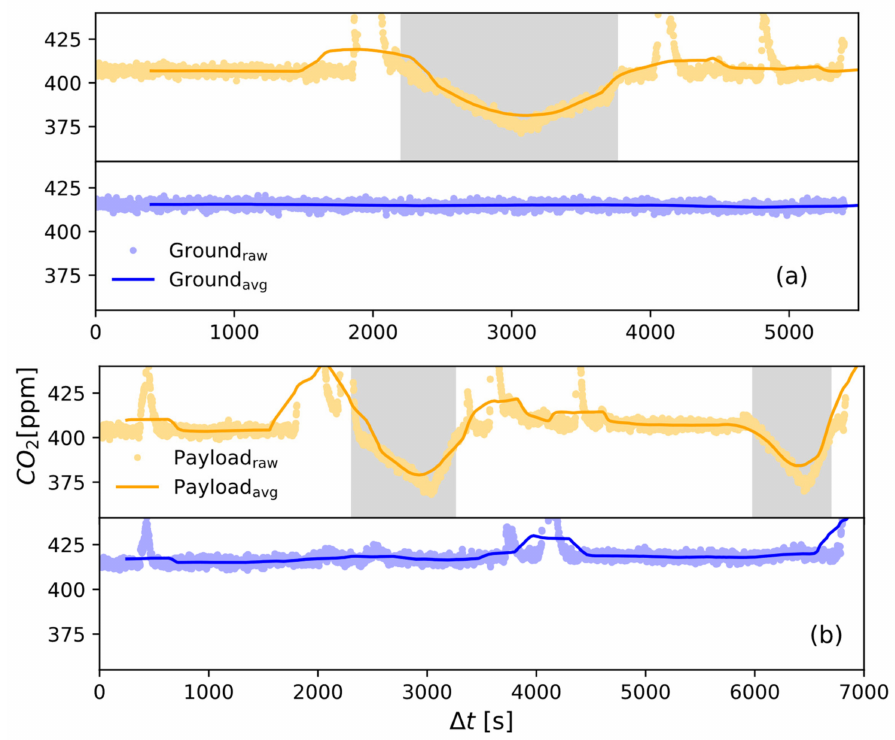
Figure 9. Unprocessed CO 2 measurements from payload and close-proximity ground measurment (Figure 8) for day time ( a ) and night time ( b ). Grey areas separately represent the time intervals of flight 1, 2 and 3. Without any corrections, the difference on average between the measurements of both sensors is approximately 10 ppm throughtout the